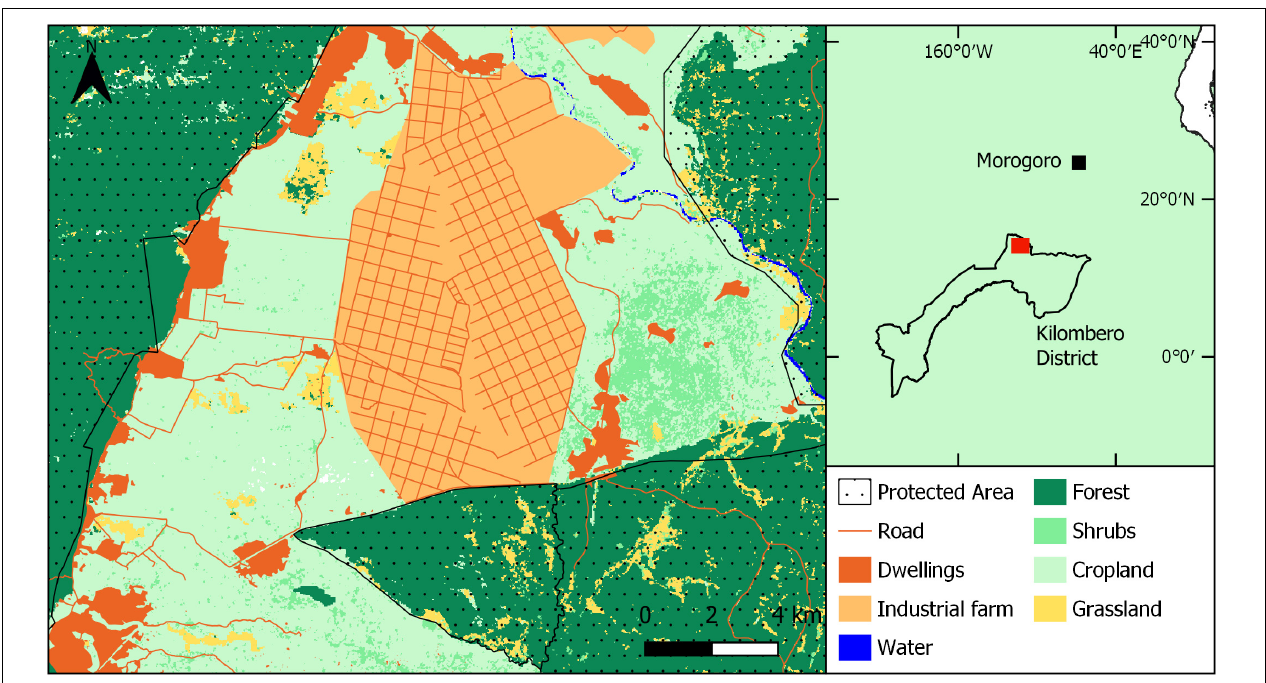
FIGURE 3 | Map of the study area in the Kilombero Valley, Tanzania. Land cover map at 20 m based on 1 year of Sentinel-2A developed by the European Space Agency (European Space Agency [ESA], 2017). Dwellings classified manually. The protected areas represented are Mikumi National Park, Udzungwa National Park, Magombera Nature Reserve, and Nyerere National Park (UNEP-WCMC and IUCN, 2021). Road data from OpenStreetMap Contributors